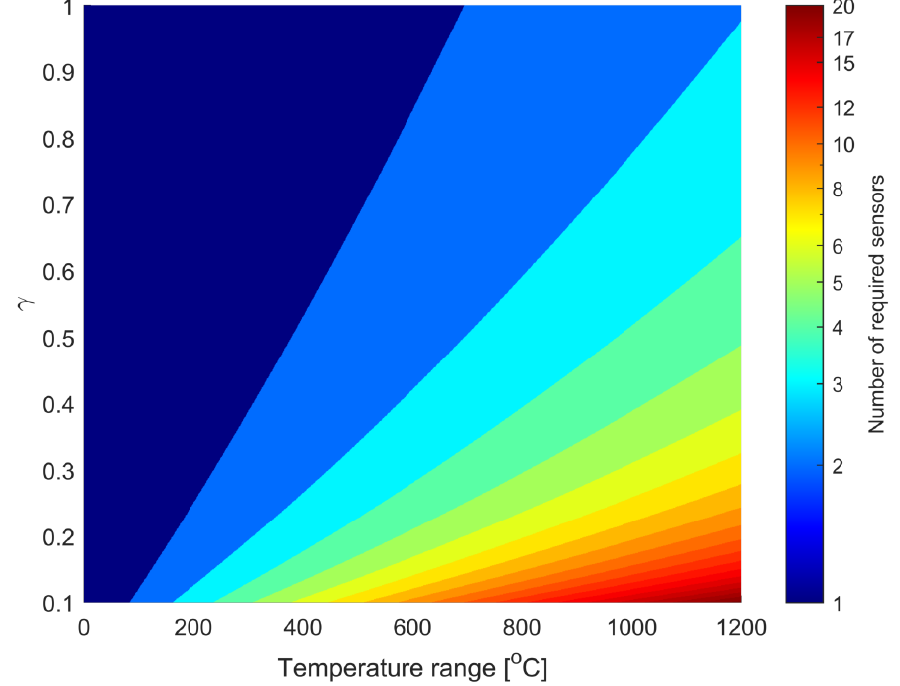
Figure 7. Relation between a number of gratings and the desired temperature measurement